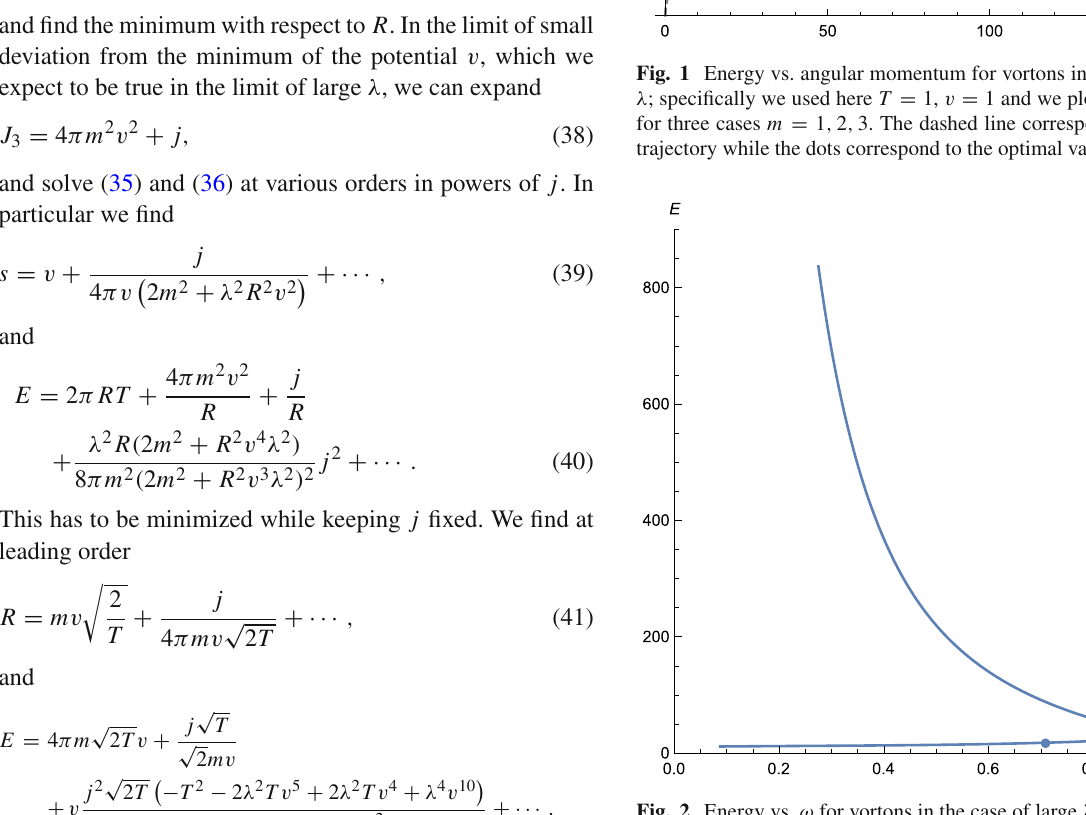
Fig. 2 Energy vs. ω for vortons in the case of large λ ; specifically we used here m = 1, T = 1, v = 1. Note the existence of a critical ω . The dot corresponds to the optimal value where s =